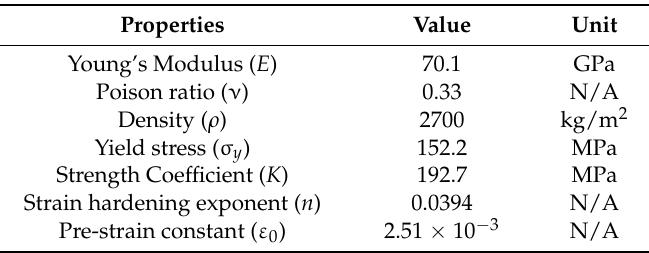
Table 1. Material properties of